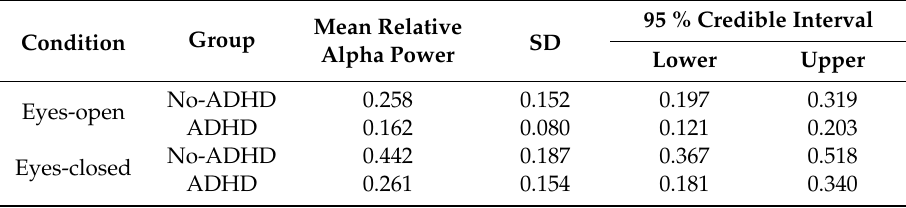
Table 2. Comparison of relative alpha power during eyes-open and eyes-closed resting-state conditions, between children with and without